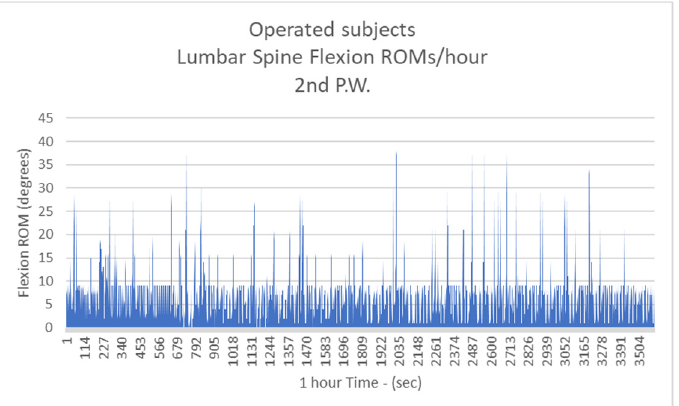
Figure 6. The number of more than 10 degrees of Lumbar Spine Flexions (LSFs) per hour for operated subjects at the 2nd postoperative week.